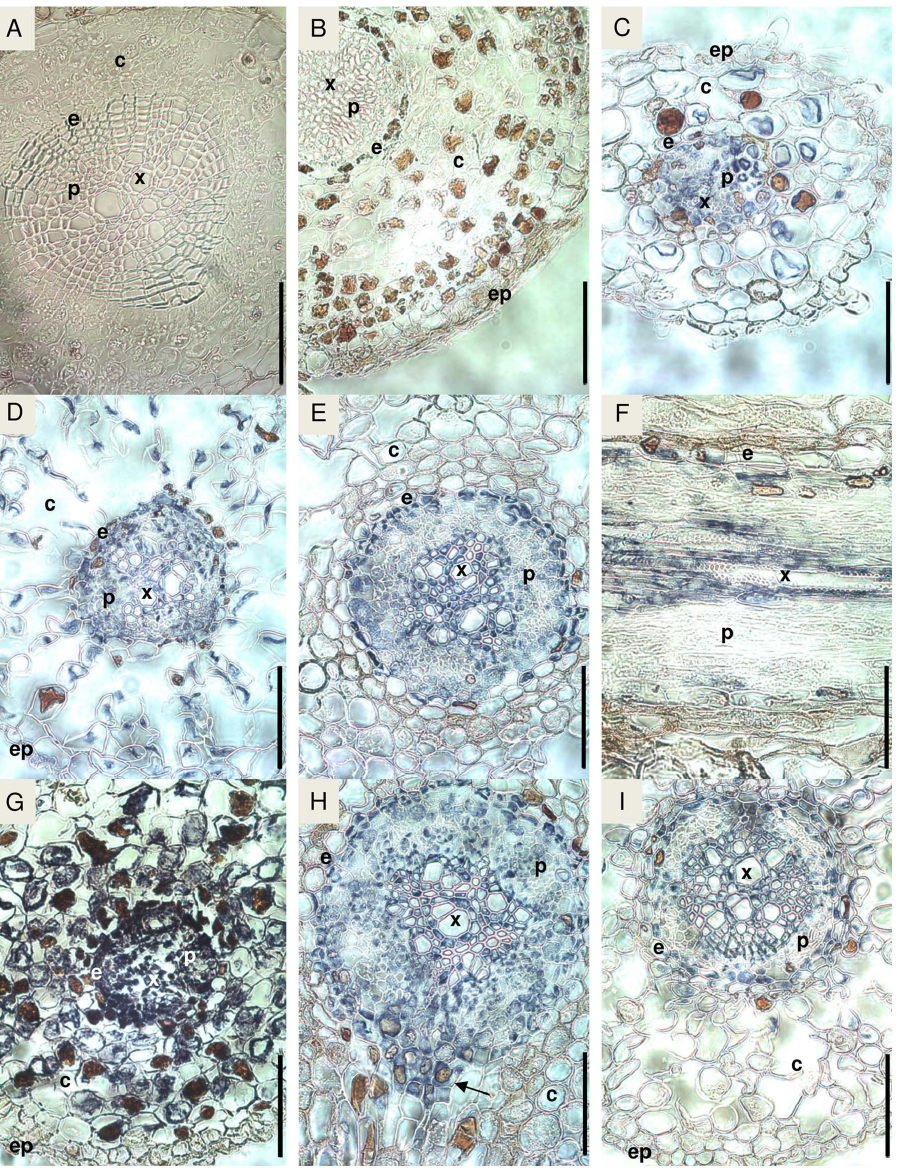
Figure 4. Immunolocalization of PttTrHb protein in hybrid aspen roots. Negative controls were obtained by root section incubated in A, without primary antibody or in B, with primary antibody preabsorbed with the recombinant PttTrHb. C to H: plant grown in normal conditions. C, Transversal section (TS) of lateral root. D, TS of adventitious root of plant rooted for 3 weeks. E, TS of adventitious root of plant rooted for 8 weeks. F, Longitudinal section of adventitious root of plant rooted for 8 weeks. G, TS of adventitious root tip of plant rooted for 8 weeks. H, TS of adventitious root of plant rooted for 8 weeks at the point of emergence of a lateral root (arrow). I, TS of adventitious root of plant rooted for 8 weeks after 5 h of SNP-treatment. c: cortex, e: endodermis, ep: epidermis, p: phloem, x: xylem. Bar = 100 m